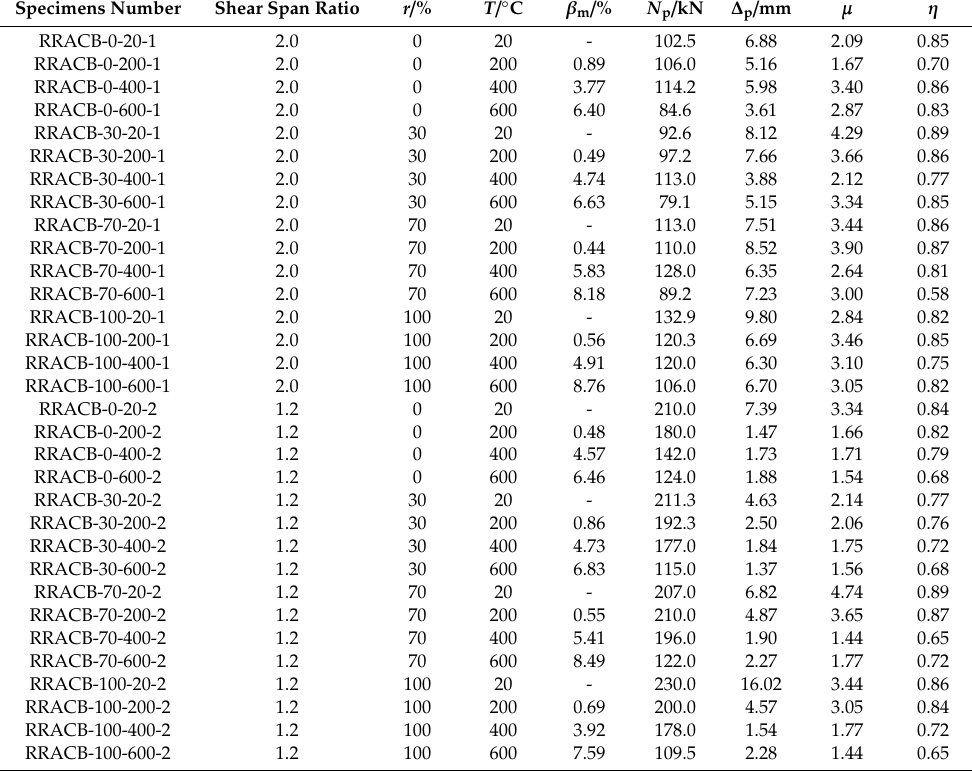
Table 6. Design parameters and experimental results of RRAC